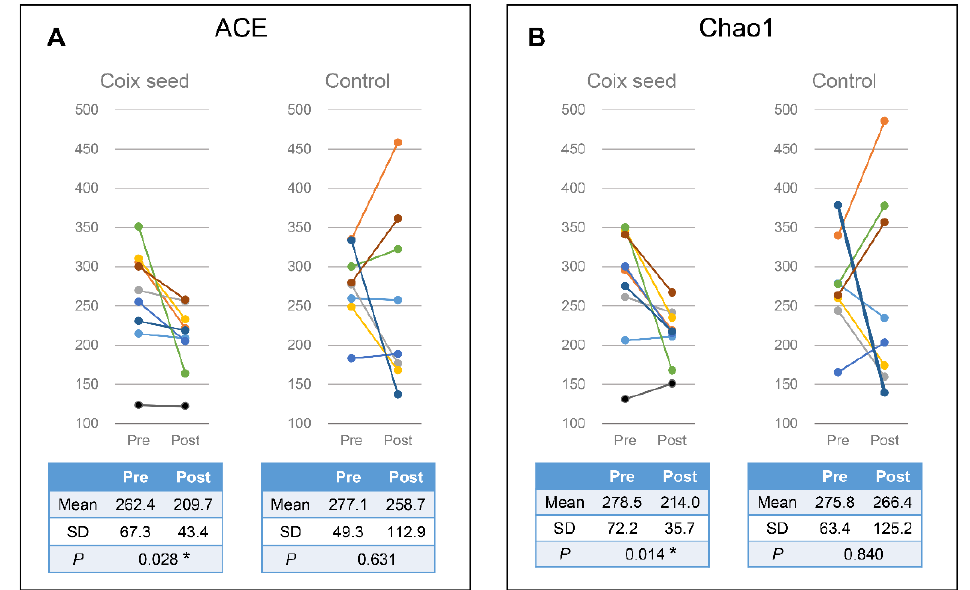
Figure 3. Alpha-diversity in the participants’ gut microbiota following either the ACE ( A ) or the Chao1 ( B ) analysis. The coix seed (CS) group showed significant decrease in both ACE ( A ) and Chao1 ( B ), whereas no change was observed in the control (CN) group.